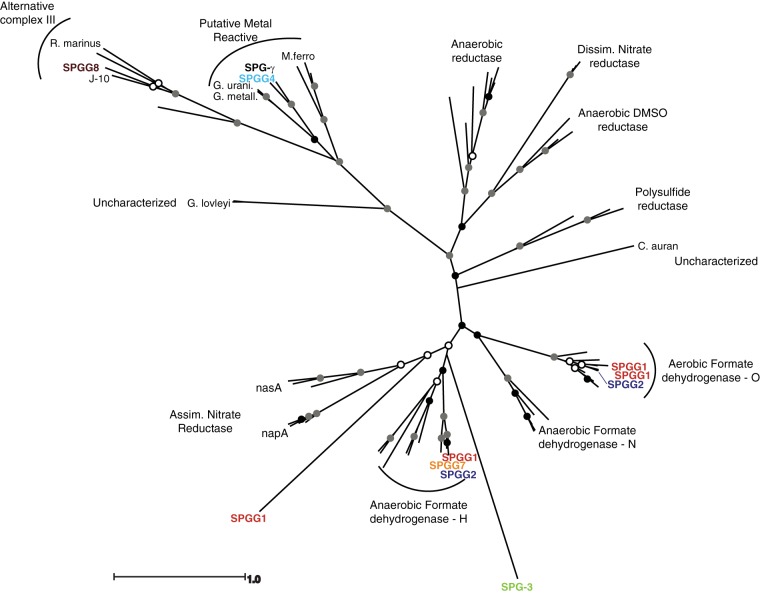
Maximum likelihood phylogenetic tree generated using PHYML based on molybdopterin oxidoreductase sequence (685-amino-acid alignment) for 67 proteins, including 10 putative CDS from the SPGGs (100 bootstrap replicates). Black circles, 100% branch support; gray circles, ≥75% branch support; white circles, ≥50% branch support. Abbreviations: SPGG-γ, unbinned Gammaproteobacteria; C. auran., Chloroflexus aurantiacus J-10; R. marinus, Rhodothermus marinus; G. urani., Geobacter uraniireducens; G. metall., Geobacter metallireducens; M. ferro., Mariprofundus ferrooxydans PV-1; napA, nitrate reductase; nasA, nitrate reductase; DMSO, dimethyl sulfoxide; Assim., assimilatory; Dissim., dissimilatory.